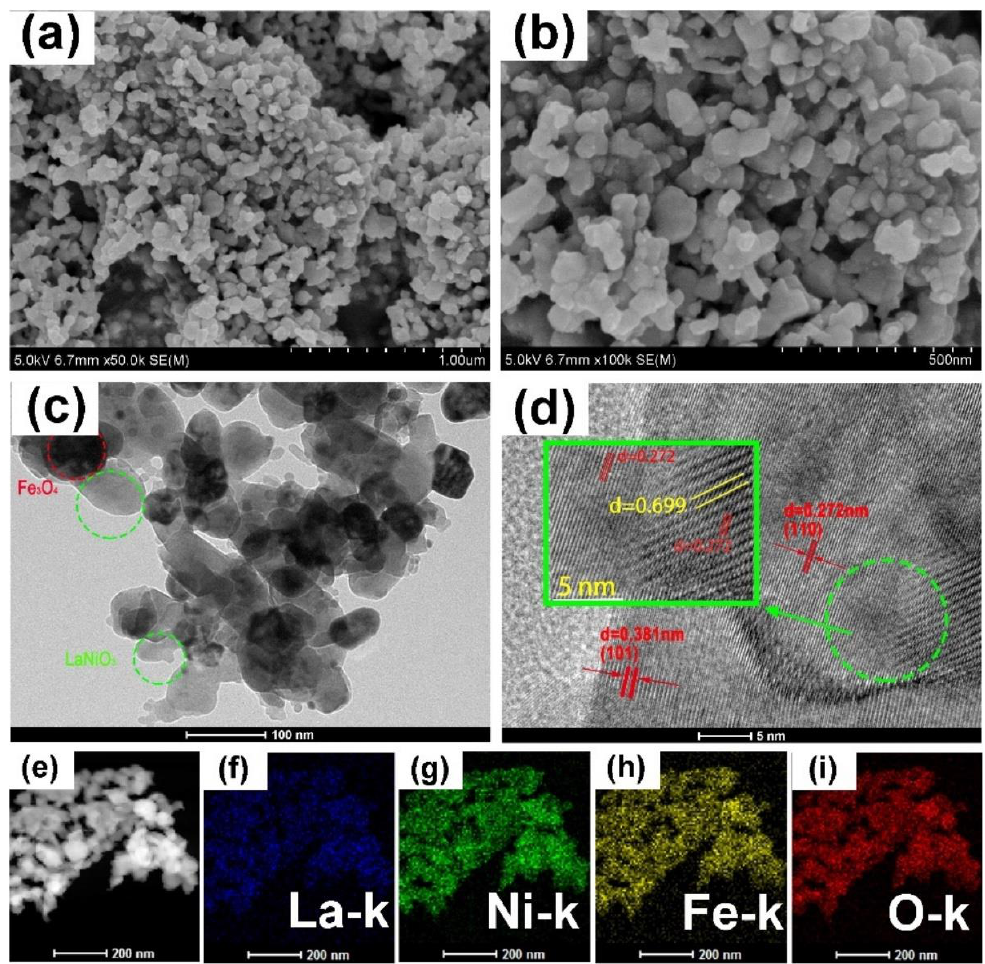
Figure 2. ( a , b ) SEM of Fe 3 O 4 /LaNiO 3 catalyst; ( c , d ) TEM and HRTEM pictures; ( e – i ) EDX element mapping.